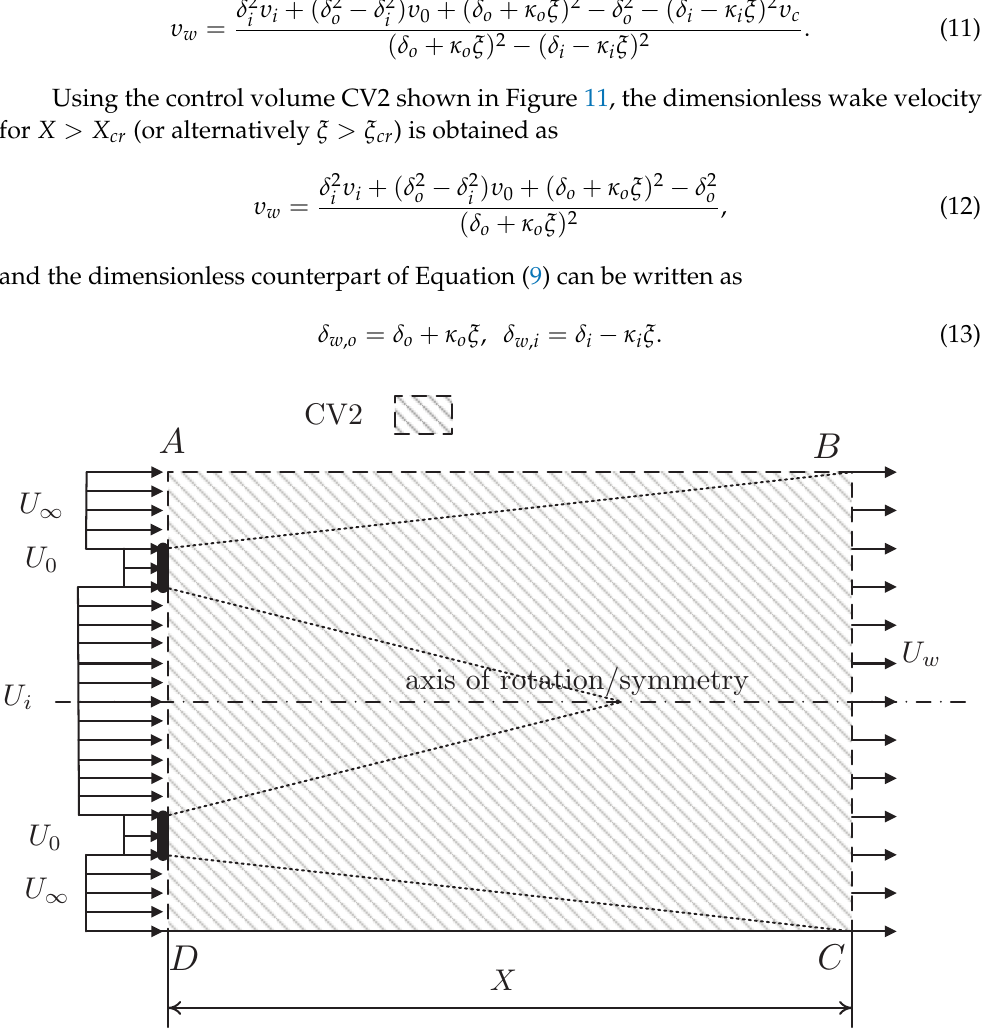
Figure 11. A schematic drawing showing the control volume CV2 (hatch pattern) whose boundaries (dashed line) are specified by ABCDA . CV2 enclose a part of the freestream, the inner flow and the wake flow (dotted line) up to X > X cr